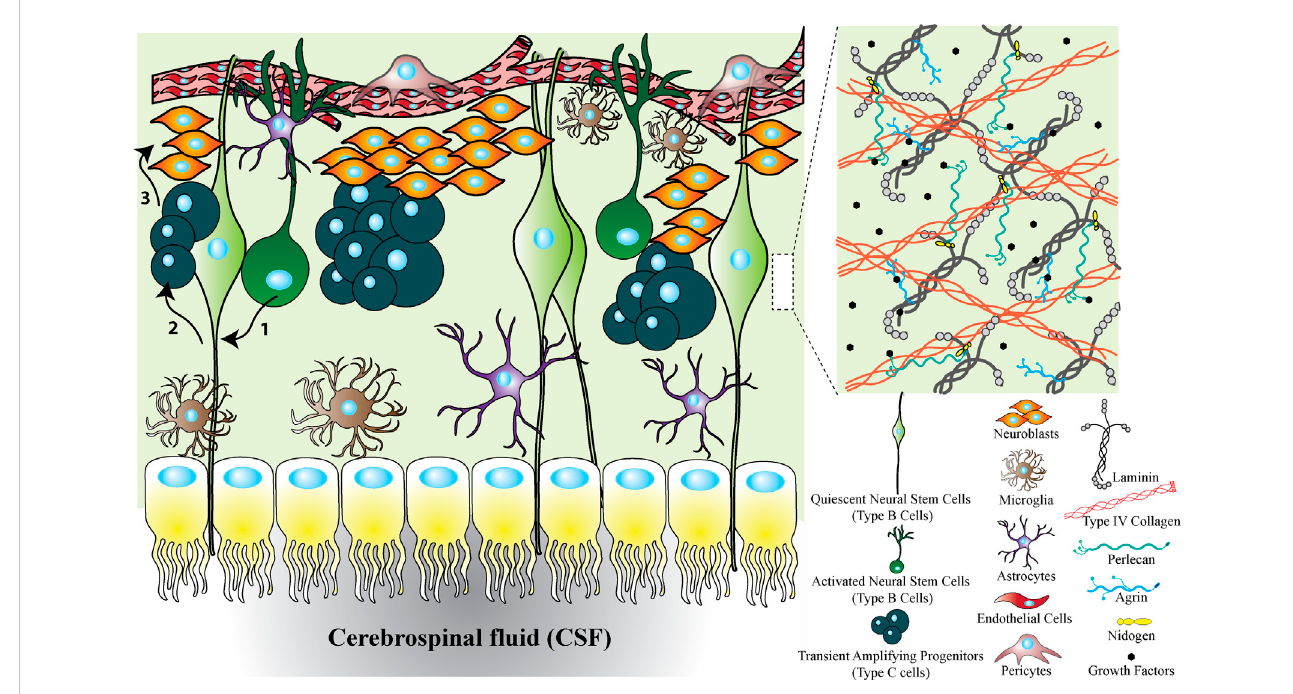
FIGURE 2 SVZnichetoshowthecellularandECMfactorsinteractingwithneuralstemcells.TheSVZnicheisformedfromdifferenttypesofcells,ECMproteinsand growthfactors.ThecellularcrosssectionshowsthattheSVZlocatedbetweentheCSFandvascularniche.Uponactivationofquiescentneuralstemcells,they transit to activated neural stem cells. Activated neural stem cells then divide symmetrically or asymmetrically to transit amplifying cells and they produce neuroblasts. Finally, neuroblasts migrate through rostral migratory stream to olfactory bulb where they differentiate to mature neurons. In addition to cells,theECMformingtheSVZnicheismainlycomposedofinsolublefactorsincludinglaminin,collagen,HSPGs(e.g.,perlecanandagrin),andsolublefactors includinggrowthfactors.Altogether,theSVZnicheisacombinationofdifferenttypesofcells,proteinsandgrowthfactorseachofwhichcanbein fl uentialon neural stem cell fate